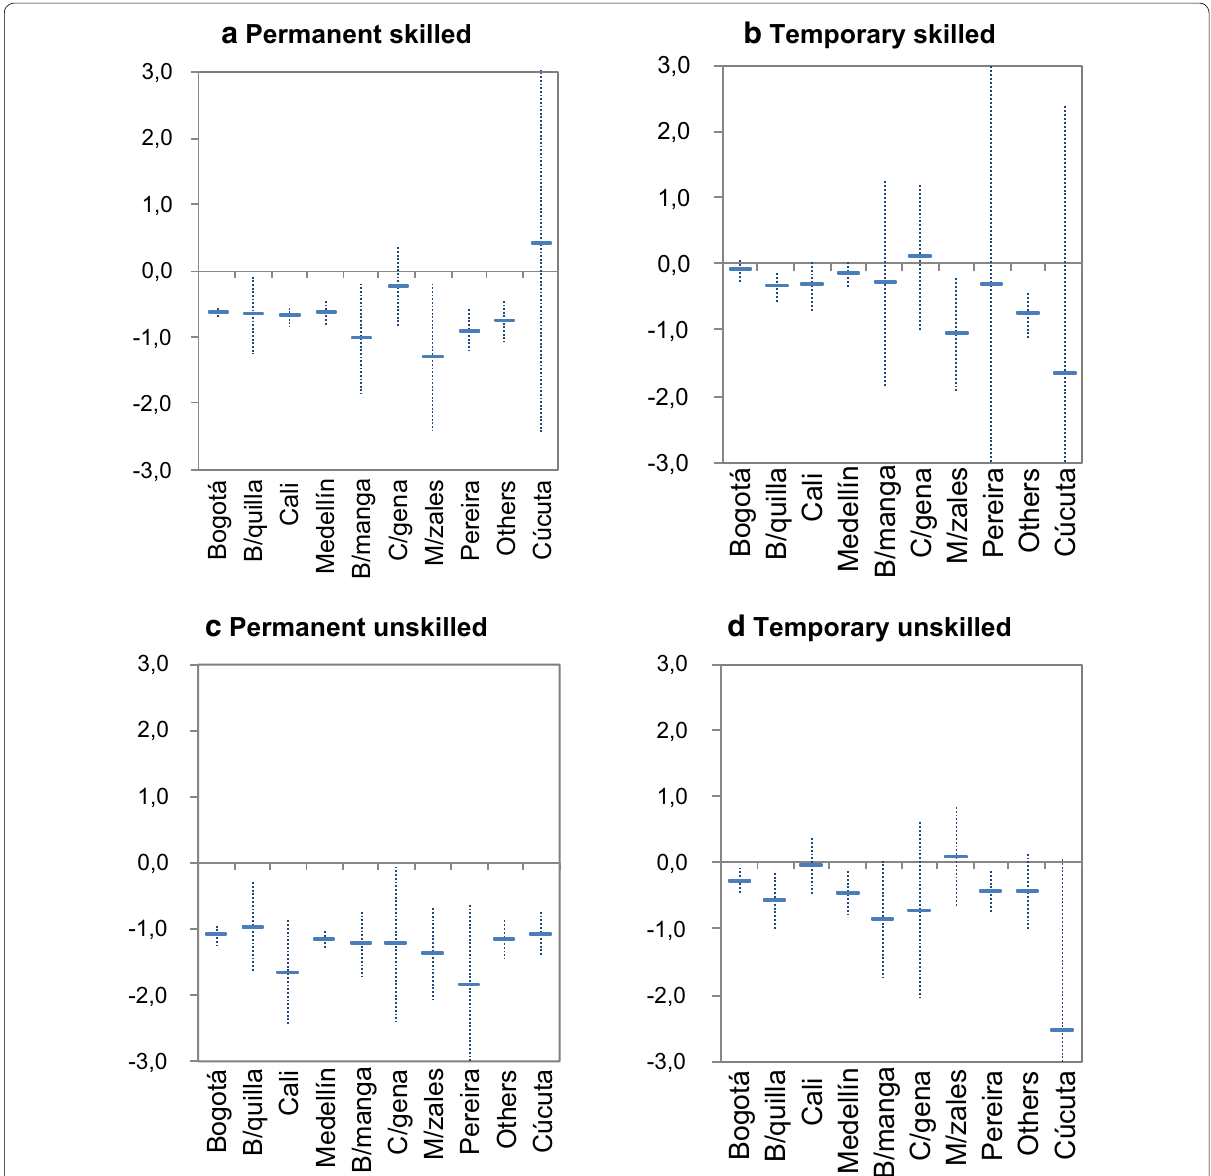
Fig. 5 Long-run own-price elasticity of conditional labour demand (2000–2013). 95% confidence intervals ( Source Dane-AMS and authors’ calculations)